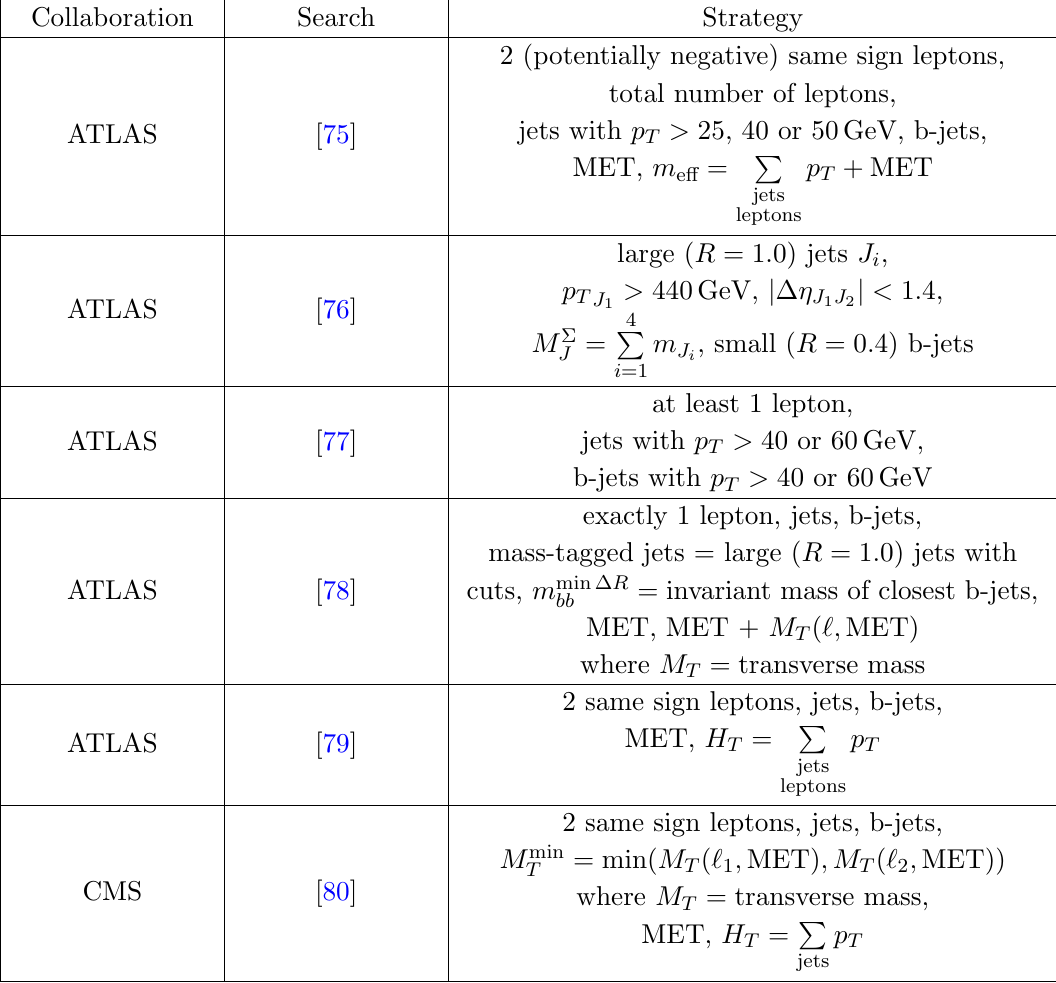
Table 2. Neutralino LSP searches. For searches [76, 78], we use FastJet [81, 82] for manipulating large ( R = 1) jets. This mainly involves jet reclustering and jet trimming. Additionally, searches that feature missing transverse energy (MET) either have very lenient cuts on this quantity or also contain signal regions probing R -parity conserving (RPC) supersymmetry